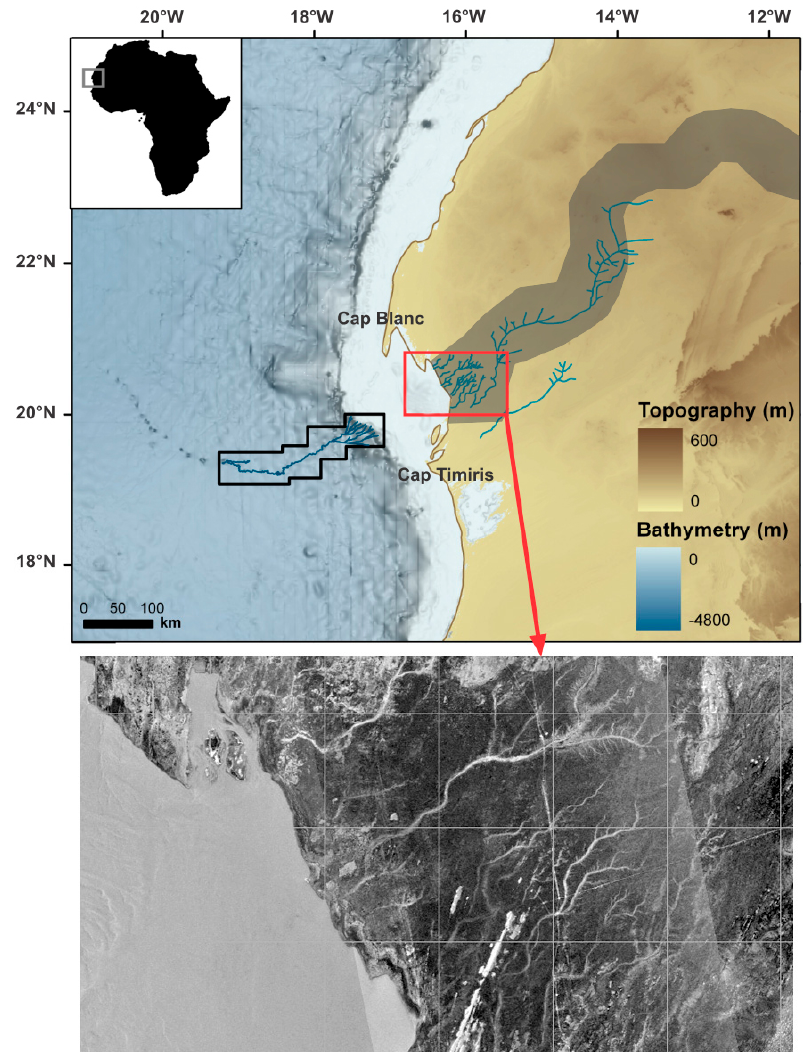
Figure 4. ( Top ) Topographic map of Mauritanian coast, showing locations of the Timiris Canyon (black square), palaeochannels detected in PALSAR data (blue lines) and Tamanrasett River valley (dark brown area), after [24]. ( Bottom ) PALSAR mosaic showing the discovered palaeodrainage system. “Radar rivers” appear here as bright features, due to the accumulation of coarse gravels in the terminal part of the channels, producing a higher radar return.